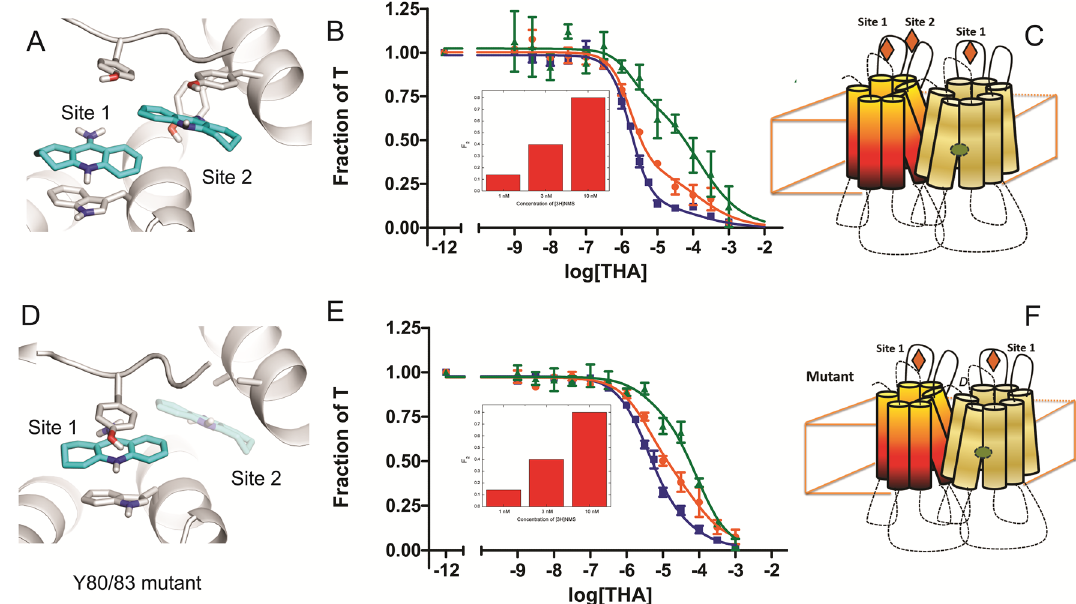
Figure 6. Structural and functional consequences of mutations at the allosteric site of the M 2 receptor. The wild-type receptor ( A – C ) and a mutant in which allosteric Site 2 was eliminated by the substitution of alanine for tyrosine at positions 80 and 83 ( D – F ) were compared in molecular dynamics simulations and in binding assays on membranes from CHO cells. ( A , D ) Simulations of receptor-bound tacrine as viewed from a position above the extracellular surface. Two allosteric sites are available on an otherwise vacant protomer of the wild- type receptor (Sites 1 and 2) ( A ), whereas only one site is available on the mutant (i.e., Site 1) ( D ) or an NMS- occupied protomer (not shown). These computations were performed using PyMOL (The PyMOL Molecular Graphics System, Version 2.0 Schrödinger, LLC; http:// www. pymol. org/). ( B , E ) Binding of tacrine. Membranes from CHO cells expressing the wild-type receptor ( B ) or the mutant ( E ) were mixed simultaneously with [ 3 H] NMS (filled square, 1 nM; filled circle, 3 nM; filled triangle, 10 nM) and tacrine at the concentrations shown on the abscissa. Binding was measured after equilibration of the mixture for 21 h at 24 °C, and the data were analyzed in terms of Eq. (3) ( n = 2). The lines in the figure depict the fitted curves, and the values of F 2 are shown in the insets. The fitted parametric values are listed in Table S10. ( C , F ) Depictions of the interaction